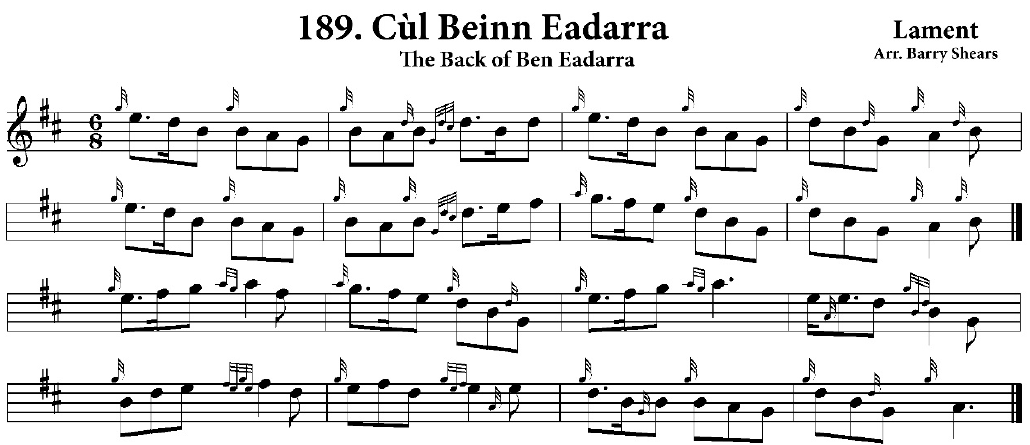
Figure 3. Cùl Beinn Eadarra ( The Back of Ben Eadarra ), reprinted from Shears, Play It Like You Sing It Vol. 2 [p. 181] with permission from Bradan Press.